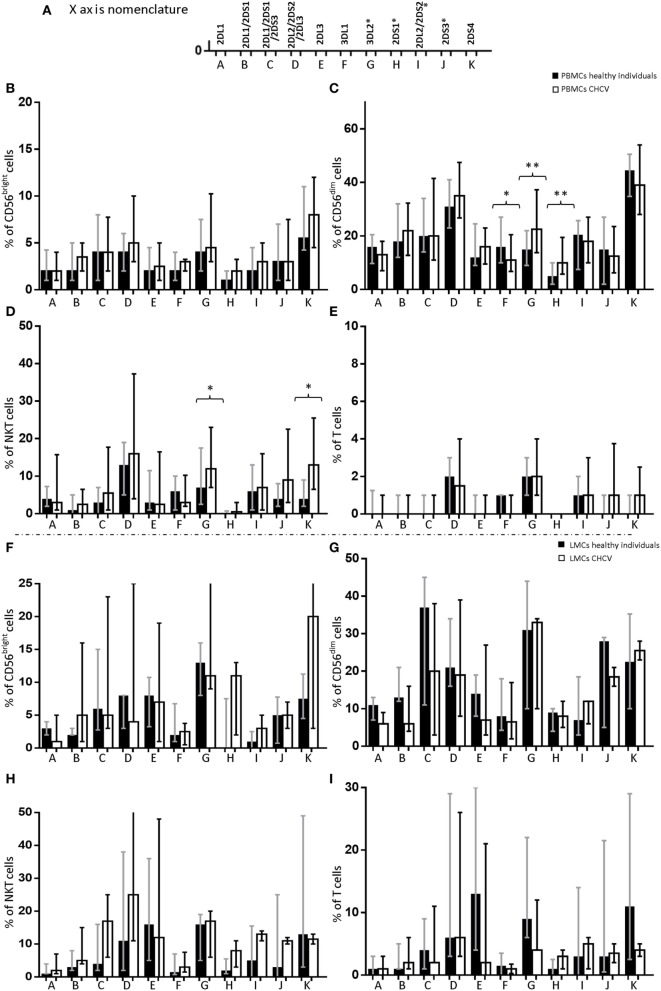
Differences in the expression of killer cell immunoglobulin-like receptor (KIR) genes in the following cell subsets from chronic HCV (CHCV) patients and healthy controls: (A) Each KIR on the X axis is represented by its corresponding letter. peripheral blood mononuclear cell (PBMCs): (B) CD56bright, (C) CD56dim, (D) NKT (CD3+CD56+), and (E) T cells; liver mononuclear cells (LMCs): (F) CD56bright, (G) CD56dim, (H), NKT (CD3+CD56+), and (I) T cells. Each bar shows the median expression of positive cells for each KIR and the IQR. *p < 0.05, **p < 0.01, Mann–Whitney U test.